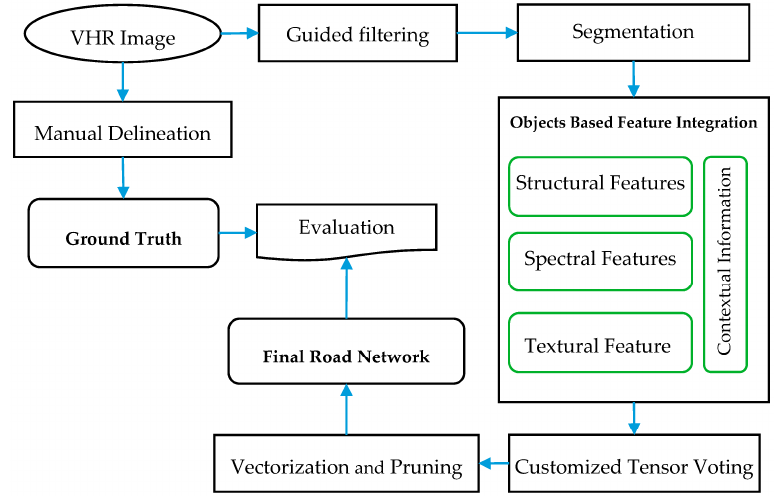
Figure 1. Workflow of the proposed approach.